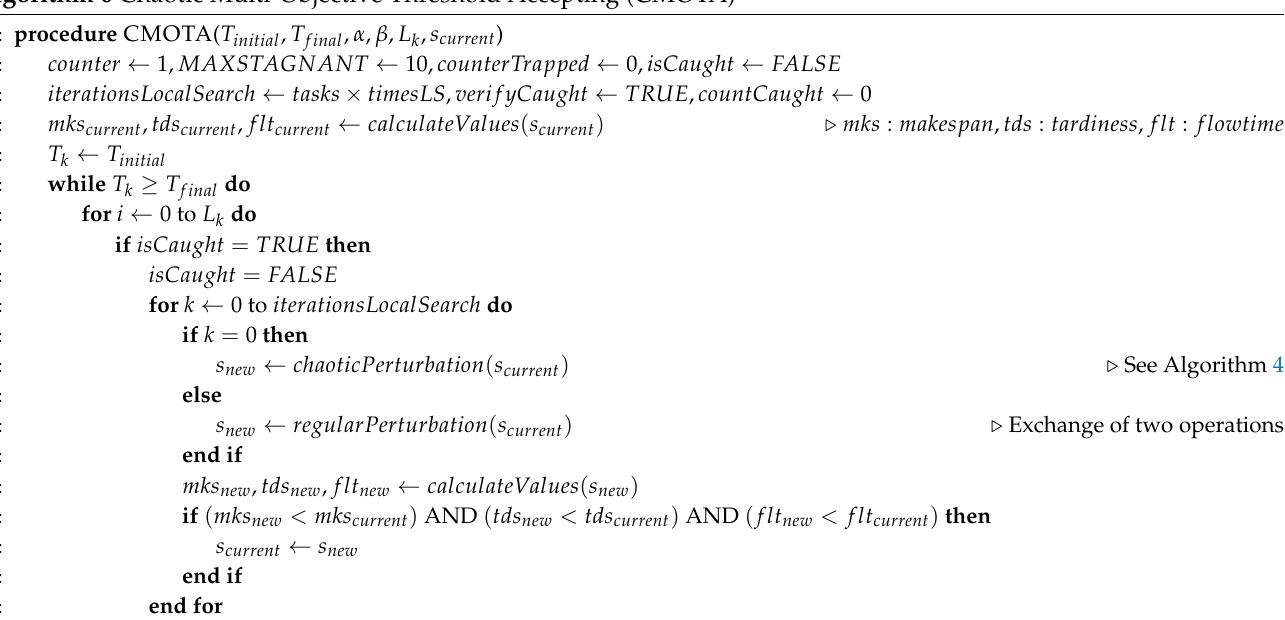
Algorithm 6 Chaotic Multi-Objective Threshold Accepting